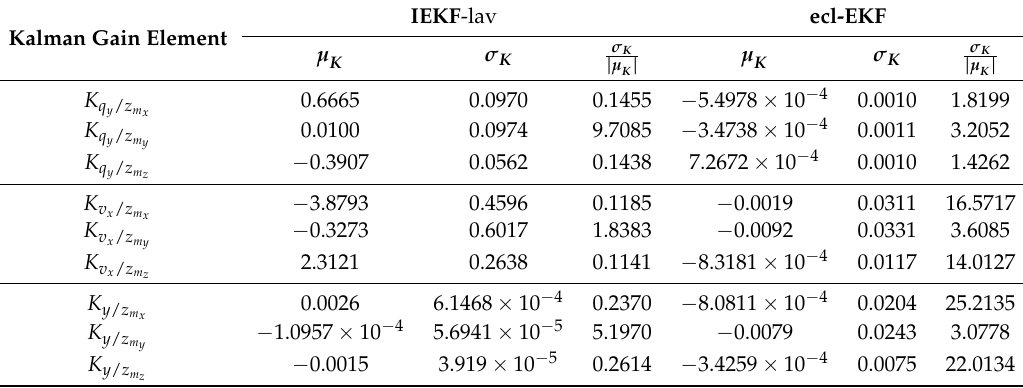
Table 5. Comparison of Kalman gain for estimation of location, attitude, and velocity in fixed wing flight test.